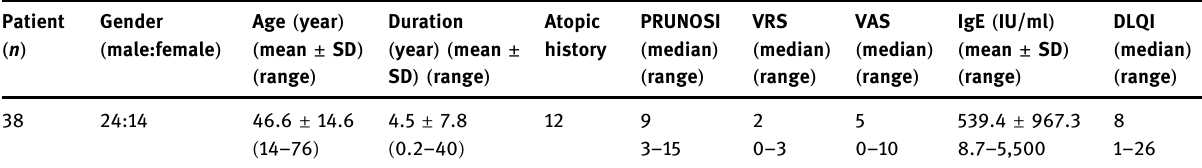
Table 1: Demographic and clinical information of patients with prurigo nodularis Patient Gender ( n ) ( male:female